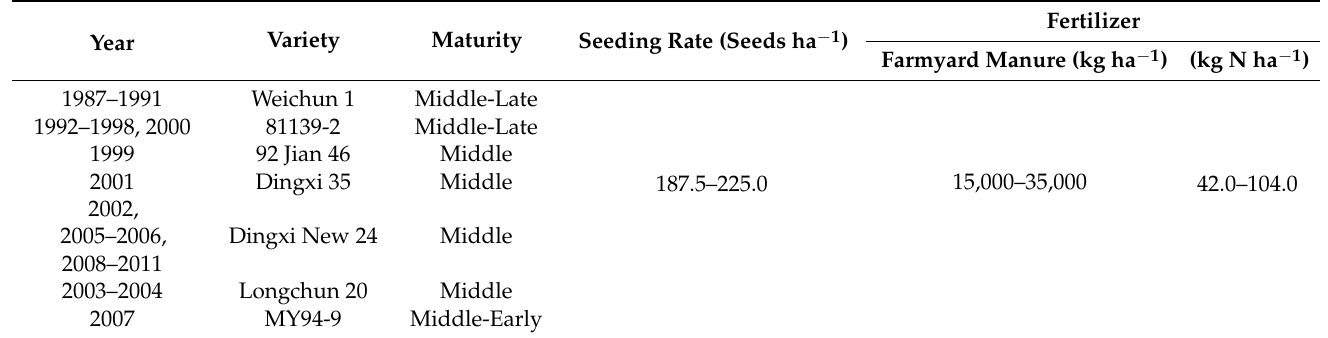
Table 2. Planting, harvesting, and fertilizing details for spring wheat at the Dingxi Experimental Station, 1987–2011.